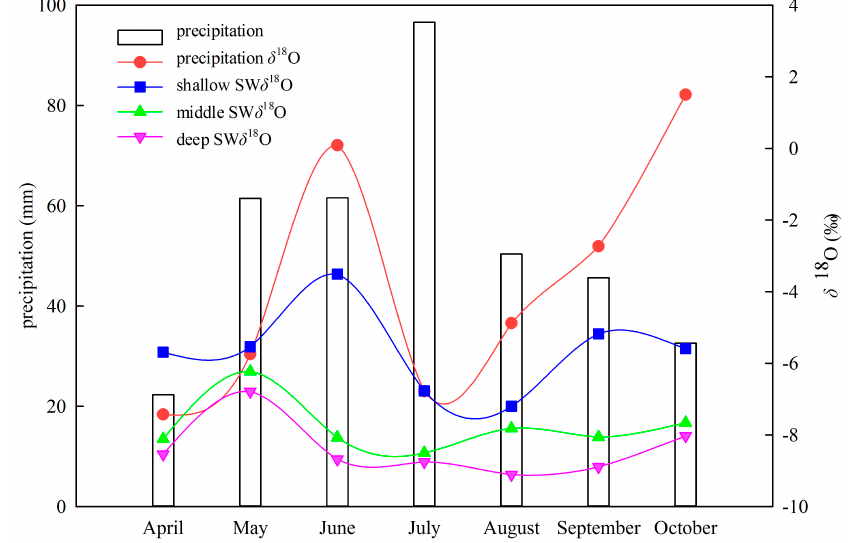
Figure 6. The monthly variation of precipitation and different depth soil water isotopes in Lanzhou.